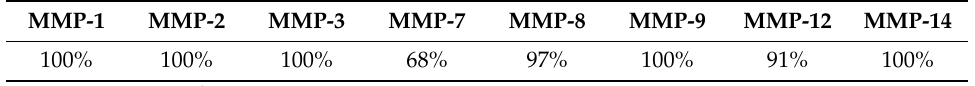
Table 1. Selectivity profile of 5 against a variety of MMPs 1 [43].